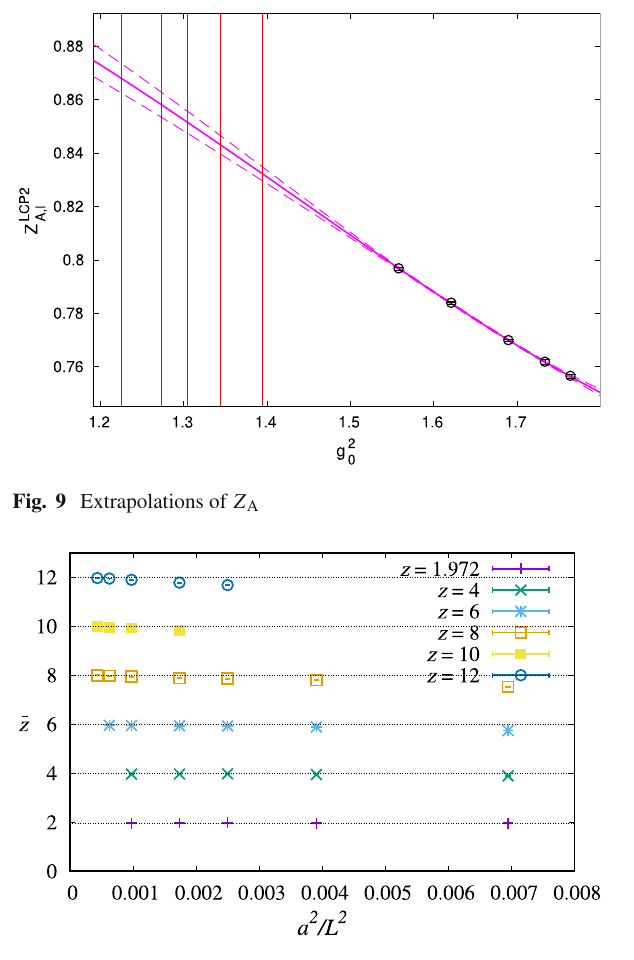
Fig. 10 Overviewofourmassivesimulationsfor M = 1 . 6 ... 9 . 5GeV, T = 2 L , showing the dimensionless RGI mass ˜ z , Eq. (E.27) which agrees well with the input z -values prescribed in terms of the bare mass m